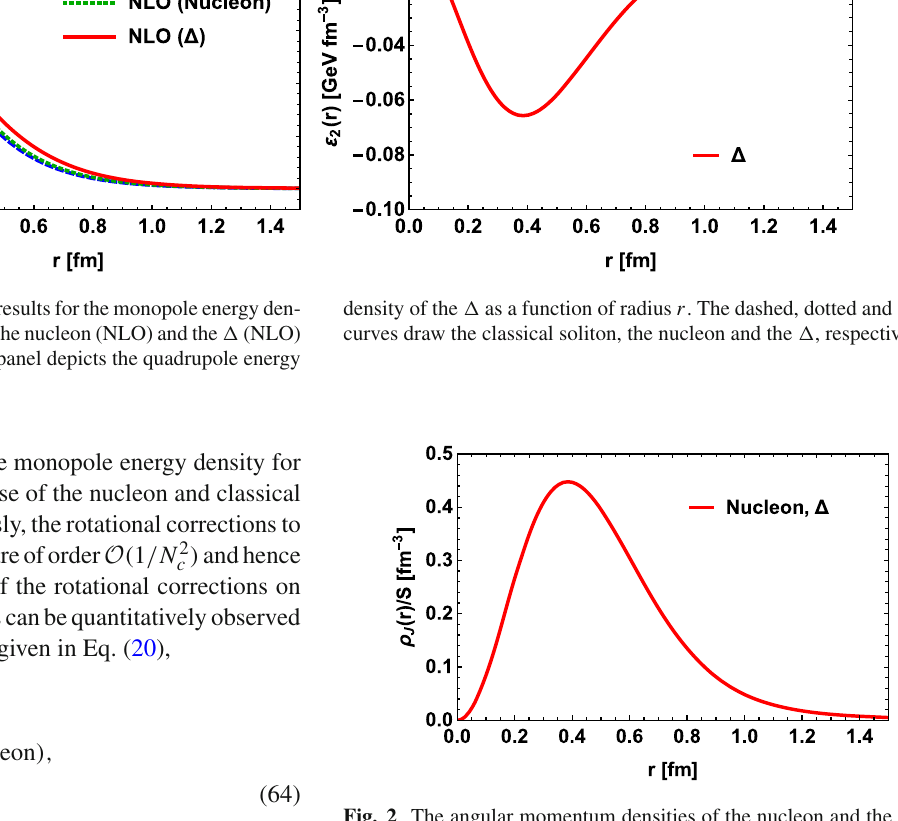
Fig. 2 The angular momentum densities of the nucleon and the (cid:2) as functions of r normalized by corresponding baryon spin S